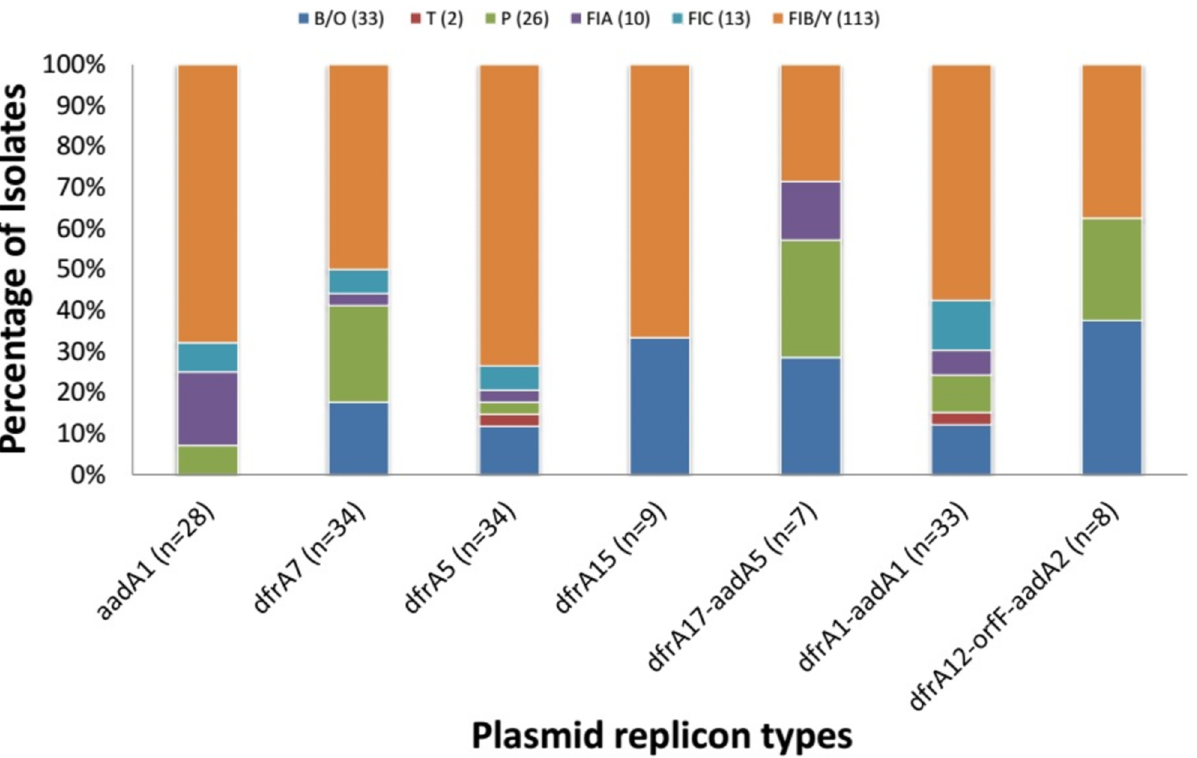
Fig 1. Plasmid replicons types detected in strains harboring only one class 1 integron cassettecombination and only one replicon markersite.